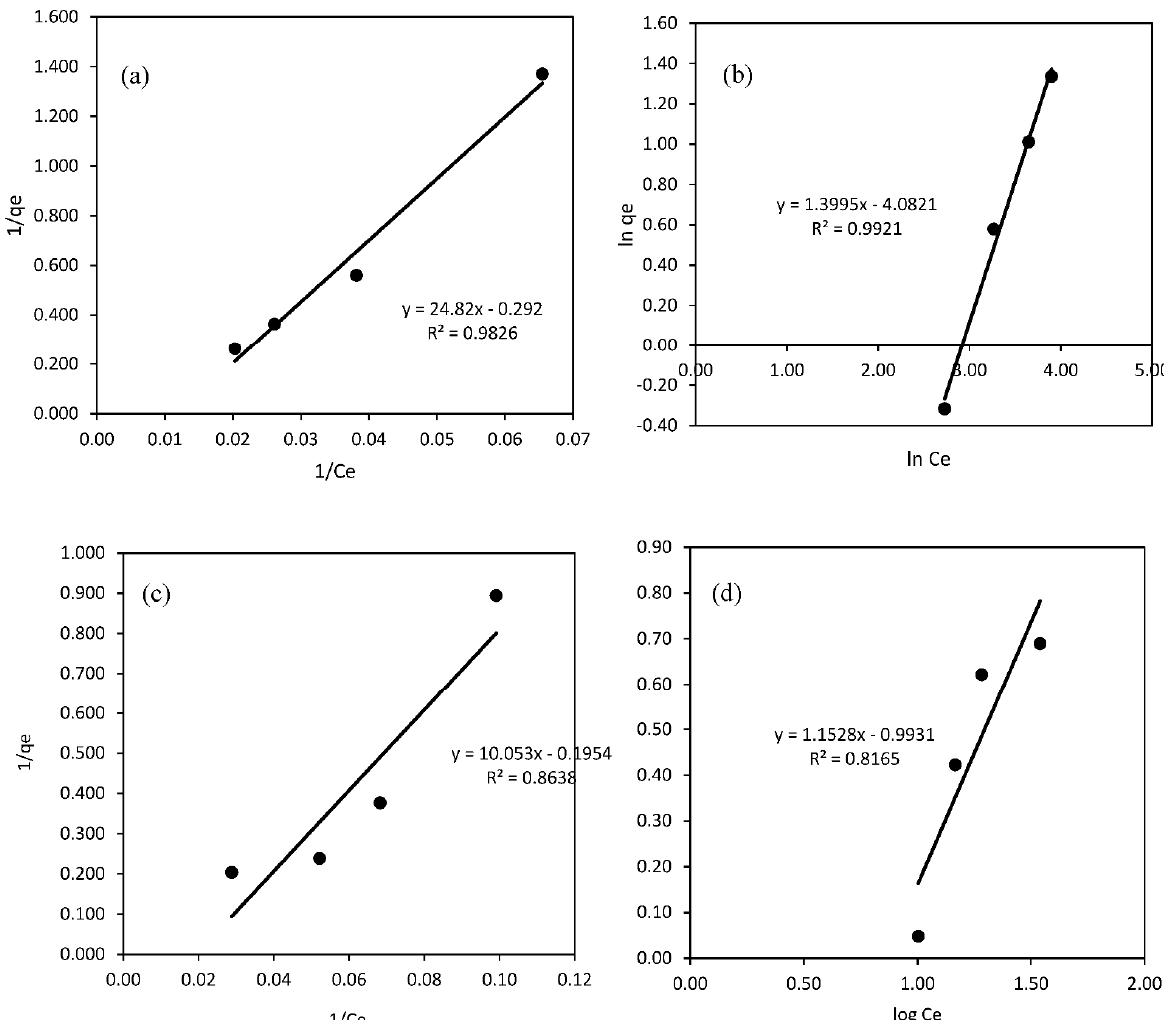
Figure 12 . Isotherm plot of ( a ) Langmuir model for SA −β− CD hydrogel ( b ) Freundlich model for Figure 12. Isotherm plot of ( a ) Langmuir model for SA − β − CD hydrogel ( b ) Freundlich model for SA −β− CD hydrogel ( c ) Langmuir model for SA −β− CD/CNTs hydrogel ( d ) Freundlich model for SA − β − CD hydrogel ( c ) Langmuir model for SA − β − CD/CNTs hydrogel ( d ) Freundlich model for SA −β− CD/CNTs hydrogel . SA − β − CD/CNTs